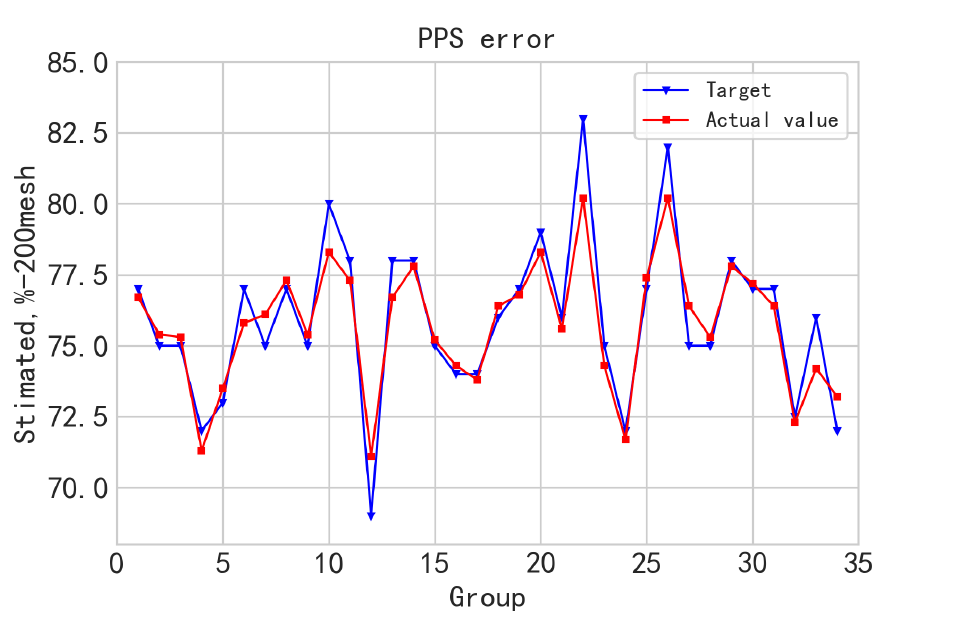
Figure 11. Target and actual value of particle size for overflow